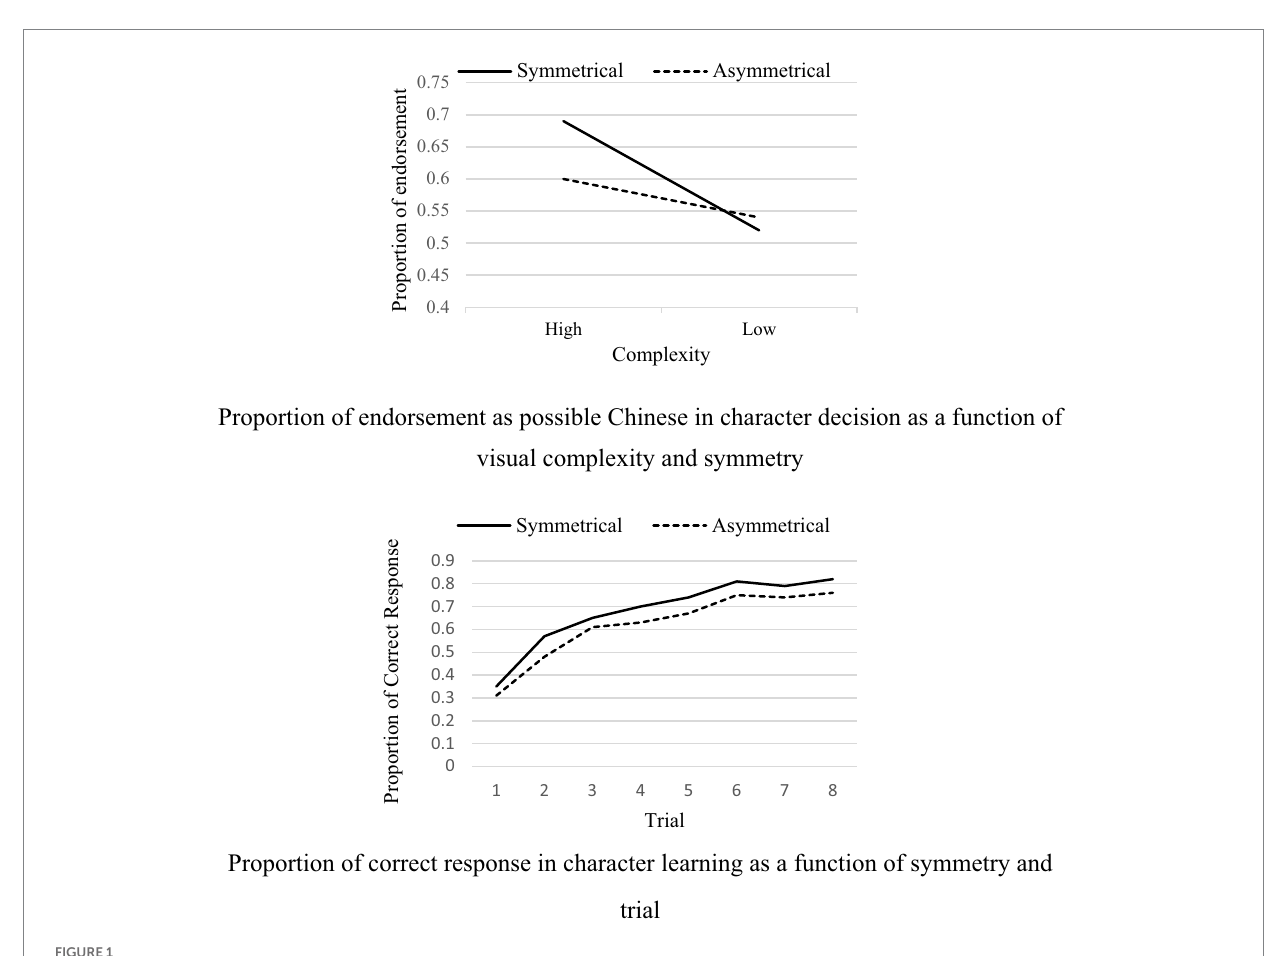
FIGURE 1 Illustration of symmetry effect in character decision in Experiment 1 (upper panel) and character learning in Experiment 2 (lower